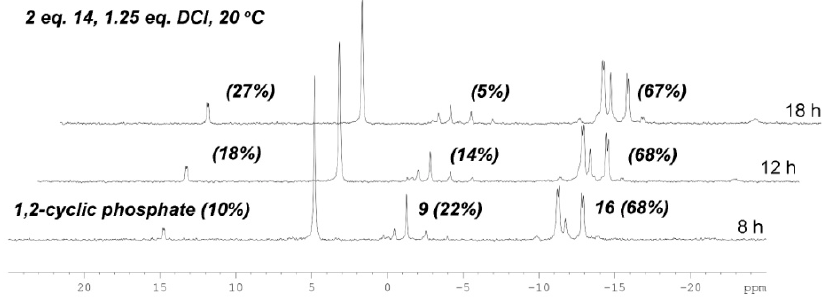
Figure 3. The composition of the coupling reaction of 9 and 14 with 1.25 equiv of DCI at different time points.